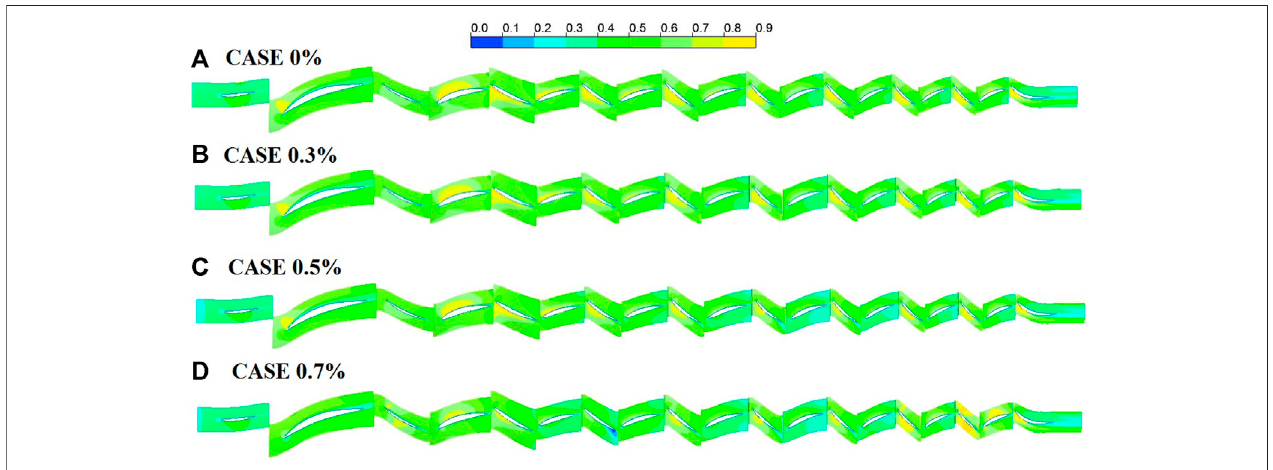
FIGURE 11 | Relative Mach number contours of 10% span at the design point of 100%n. CASE 0% (A) , CASE 0.3% (B) , CASE 0.5% (C) , CASE 0.7% (D) .